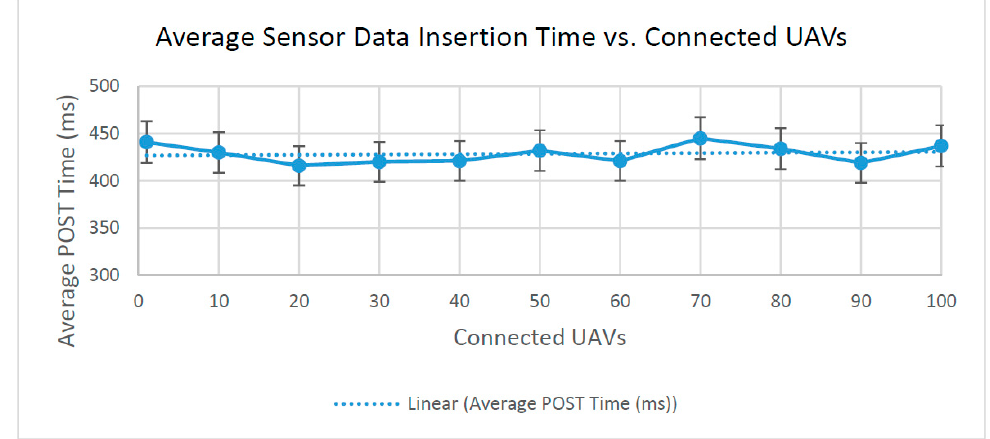
Figure 11. Average time for sensor data insertion.